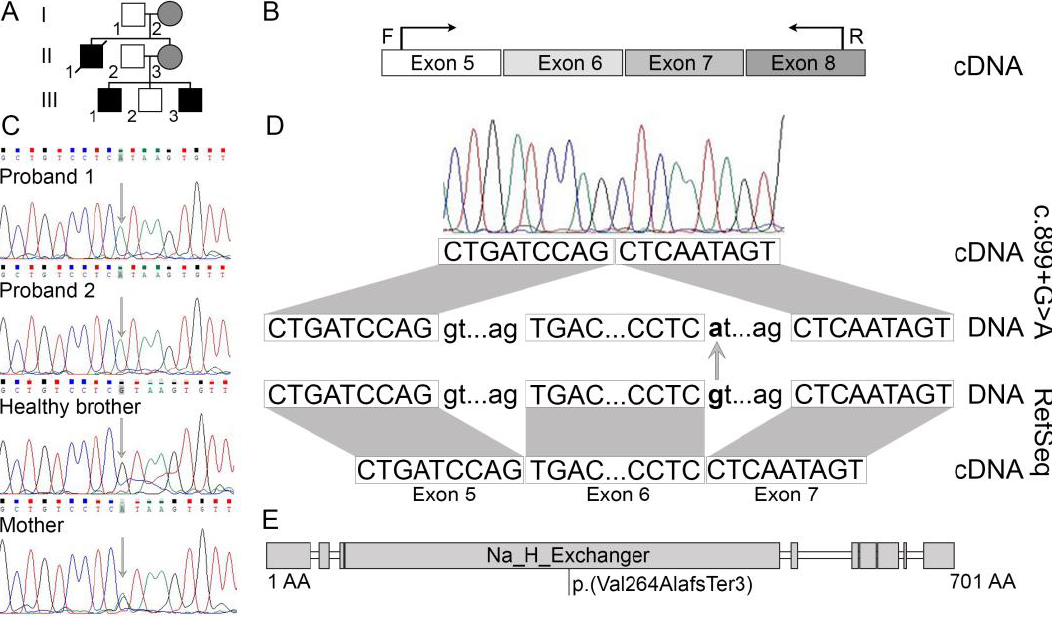
Figure 1. ( A ) — the genealogy of the family presenting two affected brothers in the third generation and affected uncle in the second generation, as well as female carriers in the second and first generations. ( B ) — schematic representation of the primers designed to amplificate specific cDNA fragment of the SLC9A6 gene. ( C ) — Sanger sequencing of DNA samples confirms the SLC9A6 splice site variant c.899 + 1G > A in proband 1, proband 2, and their mother. ( D ) — schematic representation of cDNA Sanger sequencing results showing exon 6 skipping. ( E ) — SLC9A6 protein linear representation with predicted impact of exon 6 skipping on protein leading to frameshift and premature stop codon.